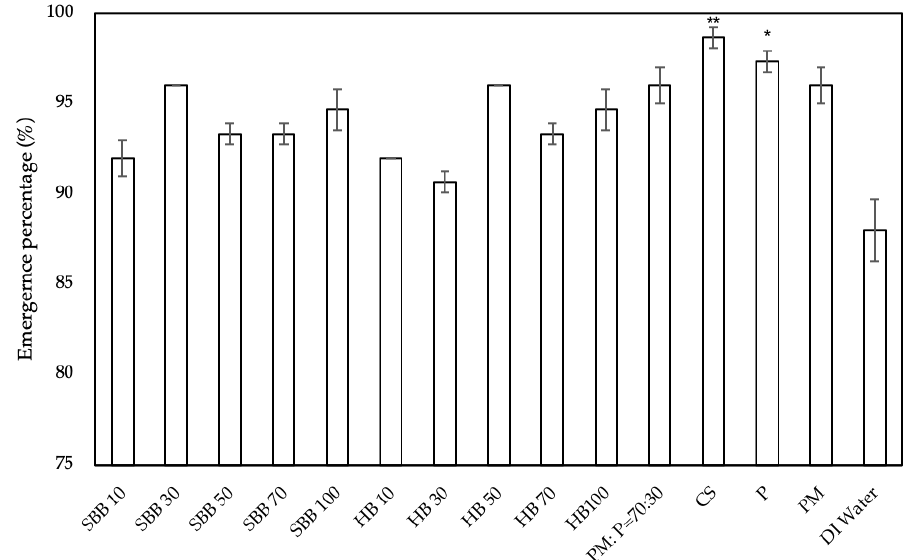
Figure 1. The emergence percentage of basil seedlings in the water extract of different mixes. *, ** indicate a significant difference from the control (DI water) using Dunnett’s test at P ≤ 0.05 and P ≤ 0.01, respectively. SBB = sugarcane bagasse biochar; HB = mixed hardwood biochar; CS = commercial propagation substrate; SBB (10%, 30%, 50%, 70% and 100%; by vol.) incorporated with 30% perlite with the rest being peat moss; HB (10%, 30%, 50% and 70%; by vol.) incorporated with peat moss.